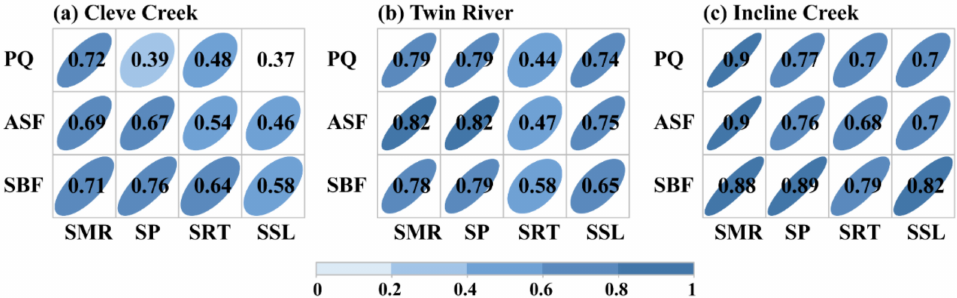
Figure 6. Correlation coefficients between snow indices (SMR, SP, SRT, and SSL) and streamflow timing variables (PQ, ASF, and SBF) at the watershed scale. The correlation is significant at the 0.05 significance level with